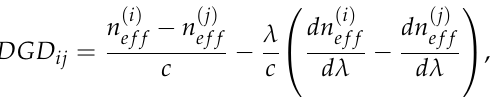
Figure 6. ( a ) Change in CL with k 1 ; ( b ) Change in CL with k 2 ; ( c ) Change in CL with k 3